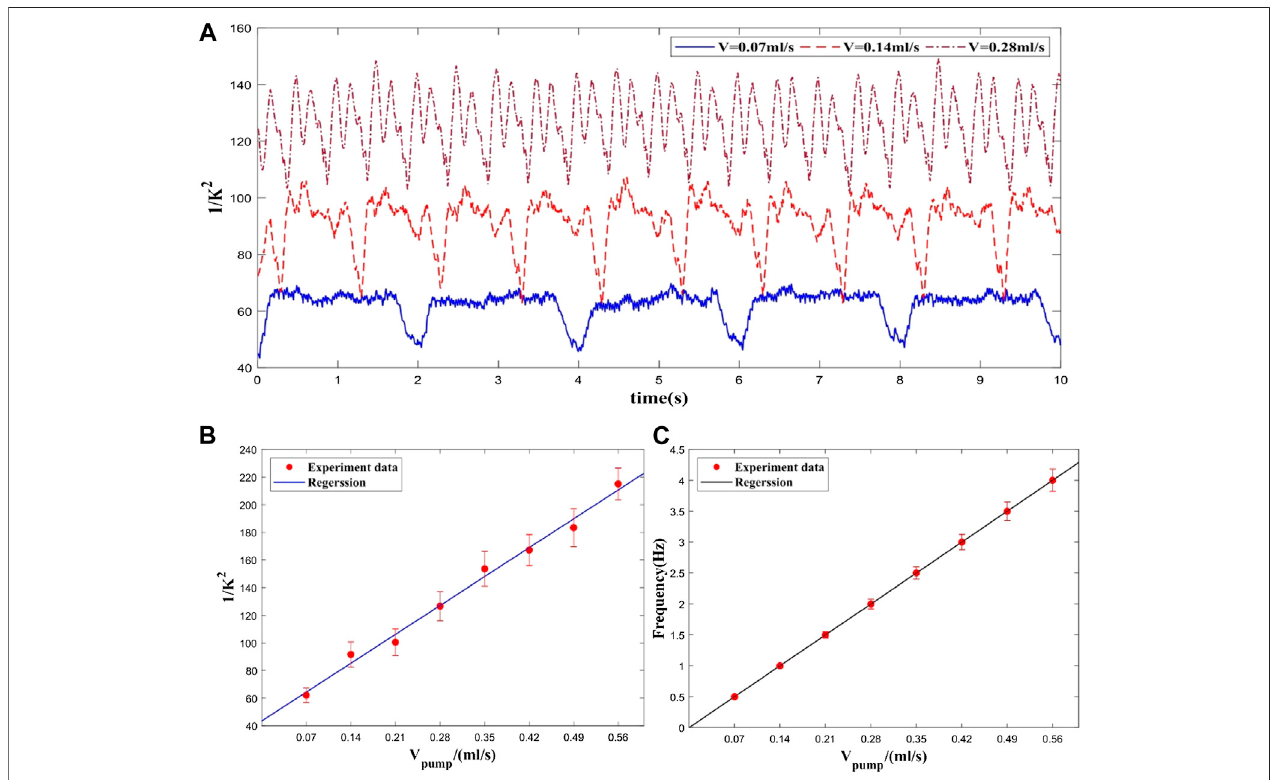
FIGURE2| Experimentalresults atdifferent fl owrates. (A) Flow ratewaveform atdifferentpumping rates(onlythree velocities), (B) Averaged fl owmeasurement at each fl ow rate. (C) Frequencies of fl ow rate waveforms at each fl ow rate.